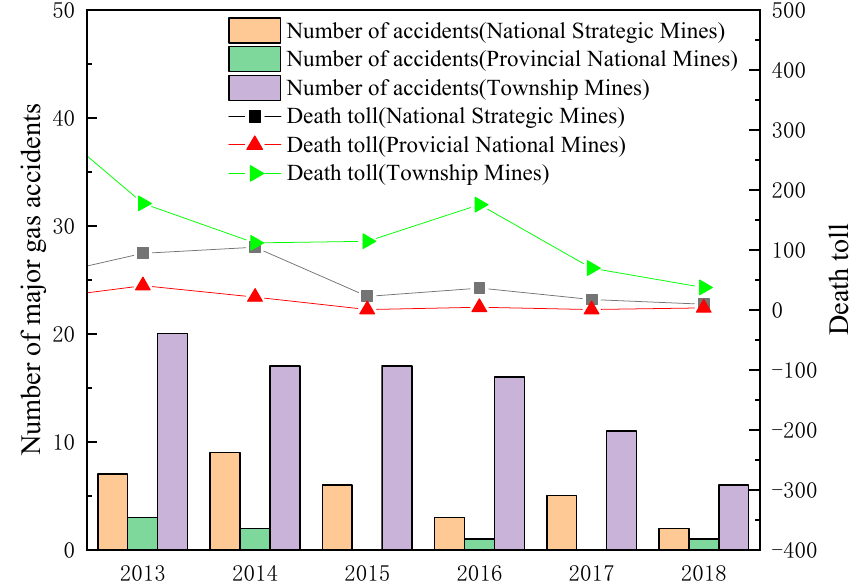
Figure 12. Changes in gas accidents in coal mines with di ff erent ownerships from 2012 to 2018.